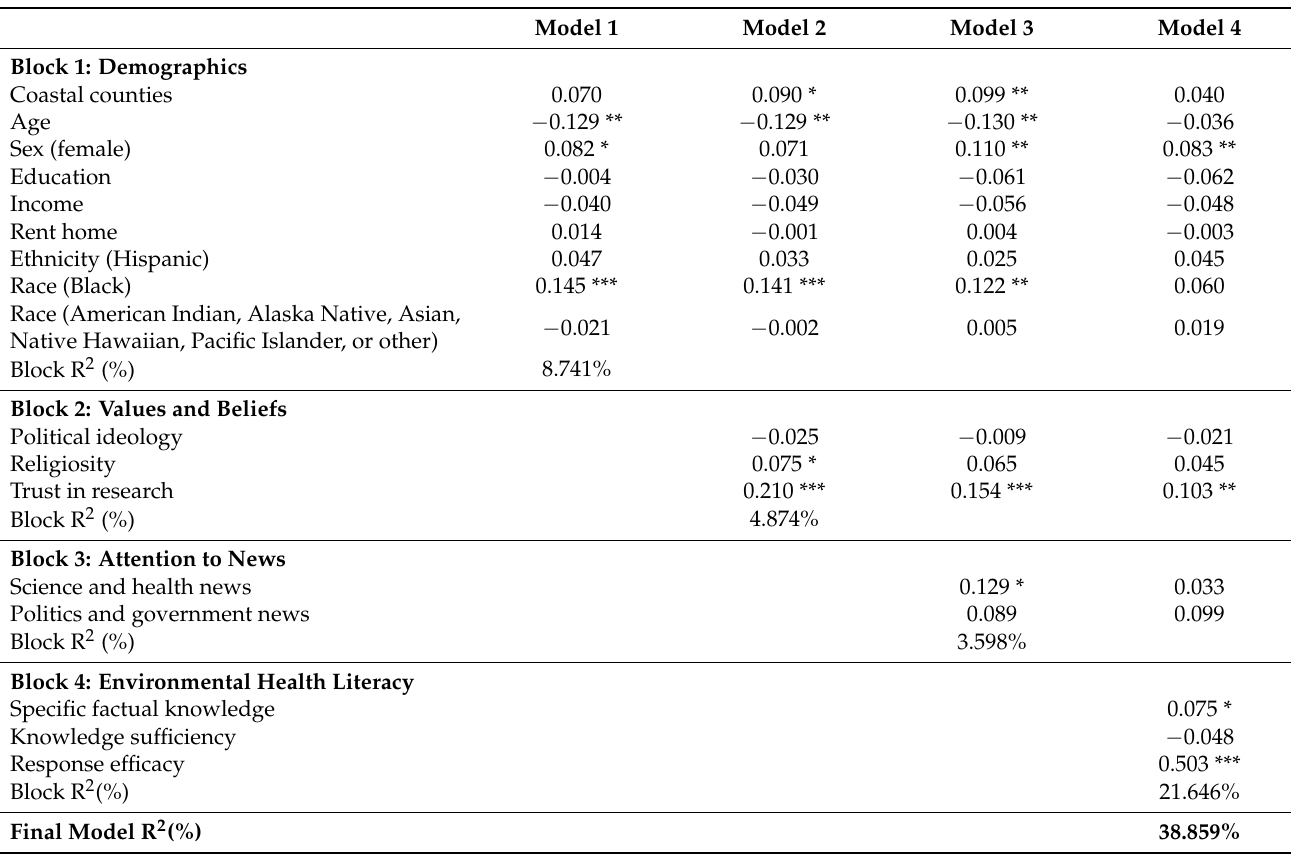
Table 2. Results of stepwise multiple regression predicting willingness to engage in protective behaviors against PFAS based on demographics, values/beliefs, news use, and environmental health literacy. N = 706 2